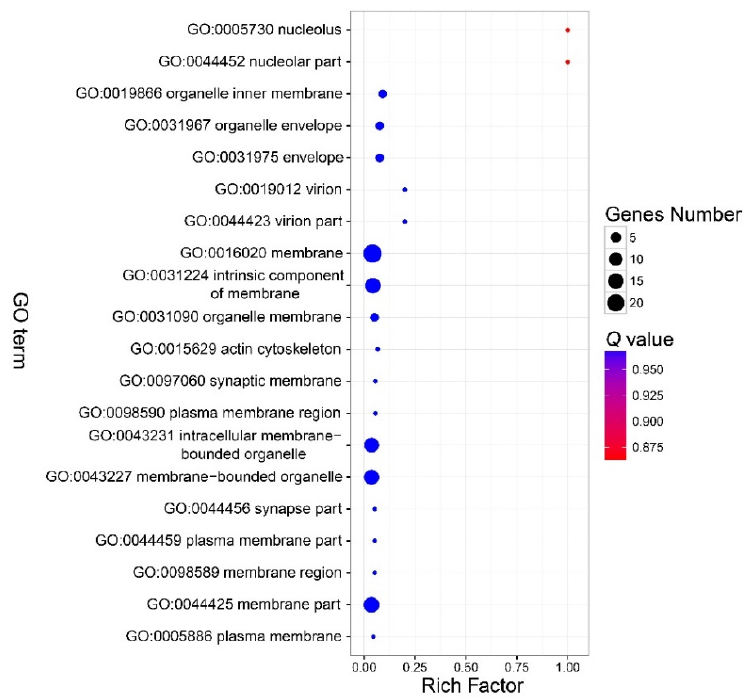
Figure 3. Bubble chart that shows the top 20 enriched GO terms in the cellular component part. No GO terms were enriched in this part. Note: The y-axis is the name of the GO term, the x-axis is the rich factor. Rich factor is the ratio of the number of the DEGs in a GO term to the number of total genes annotated to the GO term.